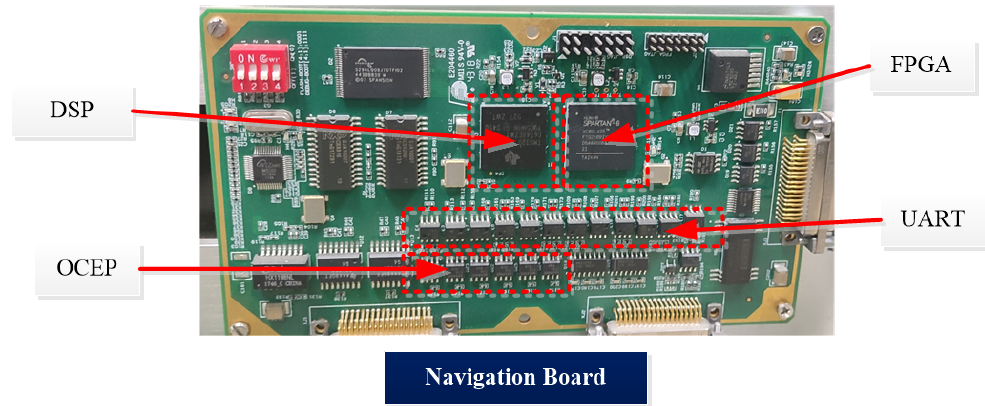
Figure 5. The circuit design of the embedded calculation and collect